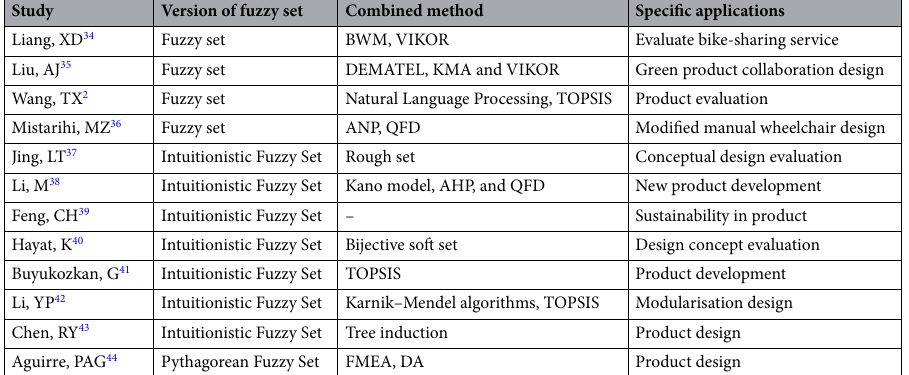
Table 1. A brief summary of research on fuzzy sets in the field of product